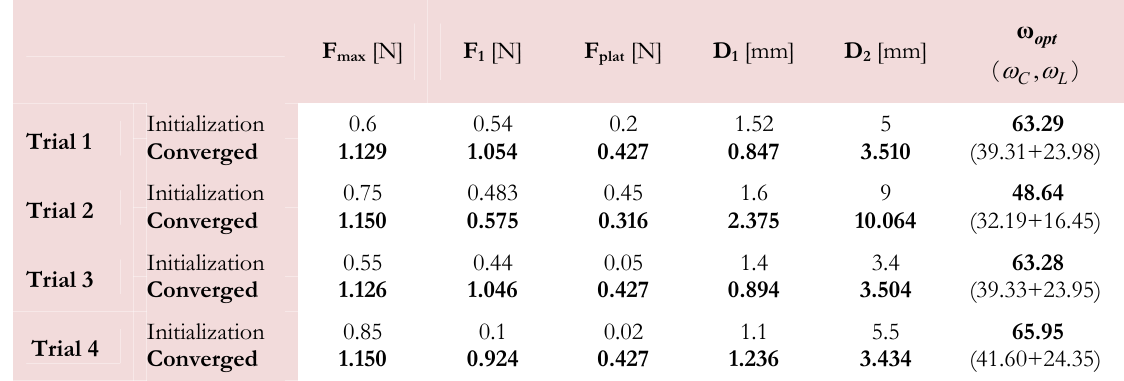
Table 1: Initialization vectors and parameter values returned by the minimization of the discrepancy function ω including contributions from both the crack opening profile (